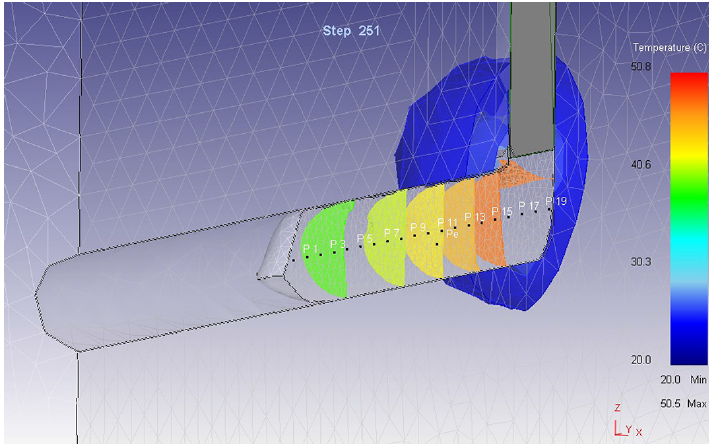
Fig.1: Temperature isosurfaces after ECAP when punch stops